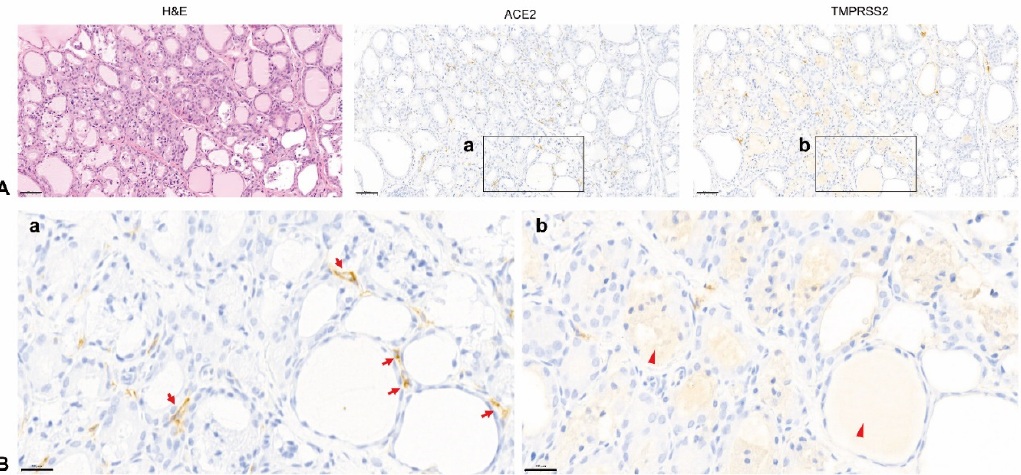
Figure 2. Immunolocalization of ACE2 and TMPRSS2 in the rat thyroid. ( A ) H&E staining (top left panel), ACE2 staining (top middle panel, brown), and TMPRSS2 staining (top right panel, brown). ACE2 and TMPRSS2 expression was observed sporadically in the whole thyroid tissue, but was not co-expressed. Scale bar = 50 μ m. ( B ) At a higher magnification, ACE2 was not stained in follicular cells but in structures that appeared to be microvessels or lymphatics (arrow) between each follicle ( a ). TMPRSS2 was mainly expressed in the colloid (arrowhead) inside the follicle, but not in the follicular cells nor microvessles ( b ). Scale bar = 20 μ m. H&E, hematoxylin and eosin; ACE2, angio-